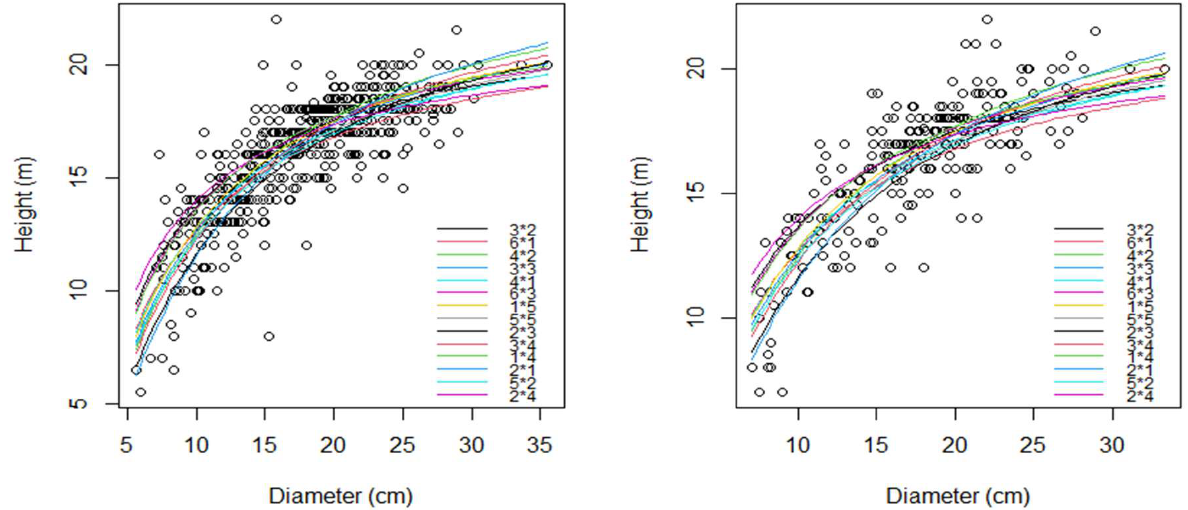
Figure 3. Height-diameter curves produced with Equation (13) corresponding to 14 combinations of M ∗ S (stand density ∗ site index; 3 ∗ 2 = stand density is class 3 and site index is class 2). The left is the height-diameter curves superimposed on the model fitting data, and the right is the height-diameter curves superimposed on the model testing data. Table 10. Evaluation indicators for the NLS model (Equation (12)), which is a non-random effect